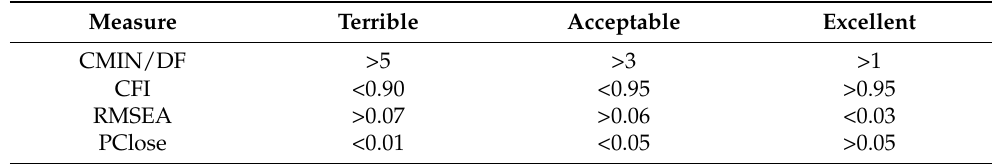
Table 7. Showing the model fit reference values